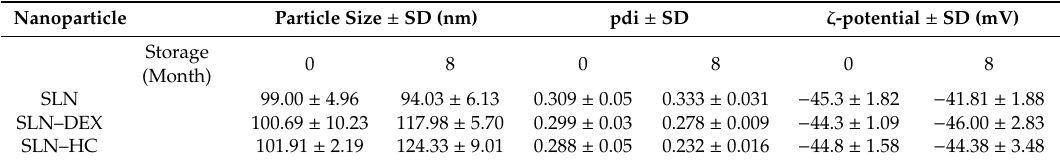
Figure 1. Particle size, polydispersity index and ζ -potential of solid lipid nanoparticles (SLNs). ( A ) Particle size, ( B ) polydispersity index (pdi) and ( C ) ζ -potential values of different SLN suspensions: empty SLNs (SLN), SLNs loaded with rhodamine (SLN–RHO), SLNs loaded with dexamethasone (SLN–DEX) and SLNs loaded with hydrocortisone (SLN–HC). Data are shown as the mean ± SEM from five independent experiments. Table 1. Characterization of SLNs with different surface chemistries.